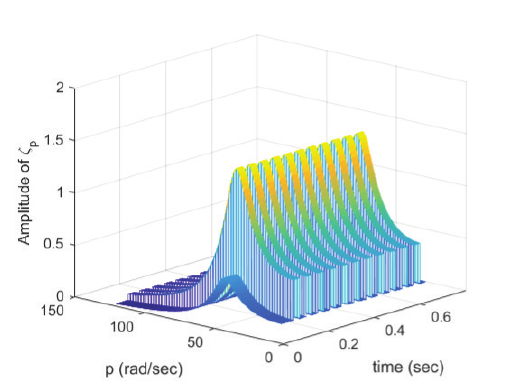
Figure 7. Time history of